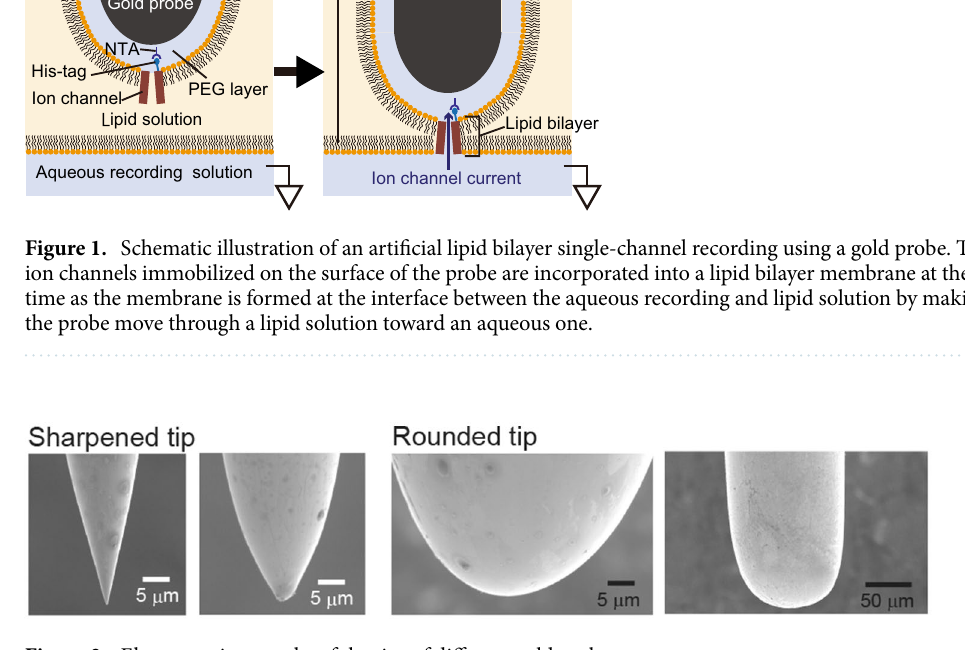
Figure 2. Electron micrographs of the tips of different gold